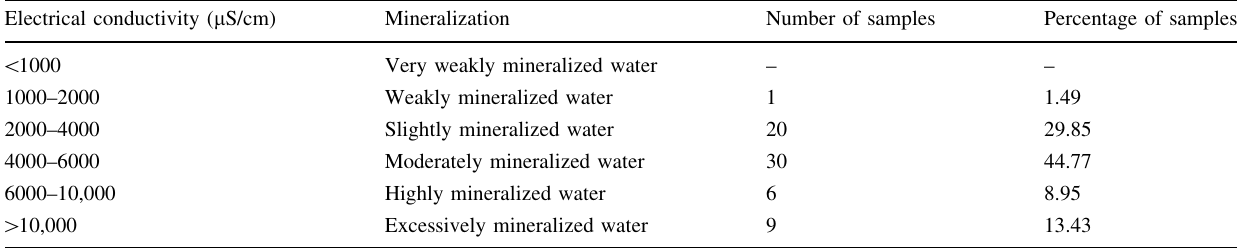
Table 3 Water classification based on electrical conductivity (Detay and Carpenter 1997) Electrical conductivity ( l S/cm)